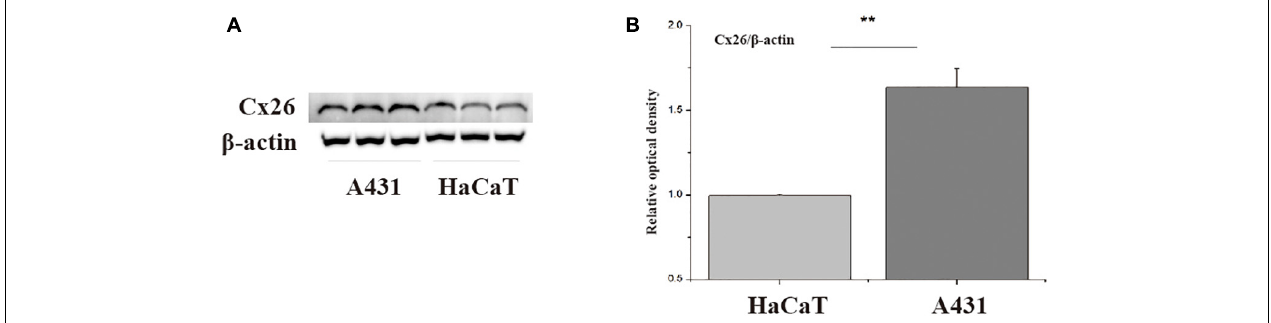
FIGURE 1 | Cx26 expression levels in A431 and HaCaT cells. (A) Cx26 expression levels in A431 and HaCaT cells. (B) Quantification of Cx26 expression in A431 and HaCaT cells. ** p < 0.01 between the two cell